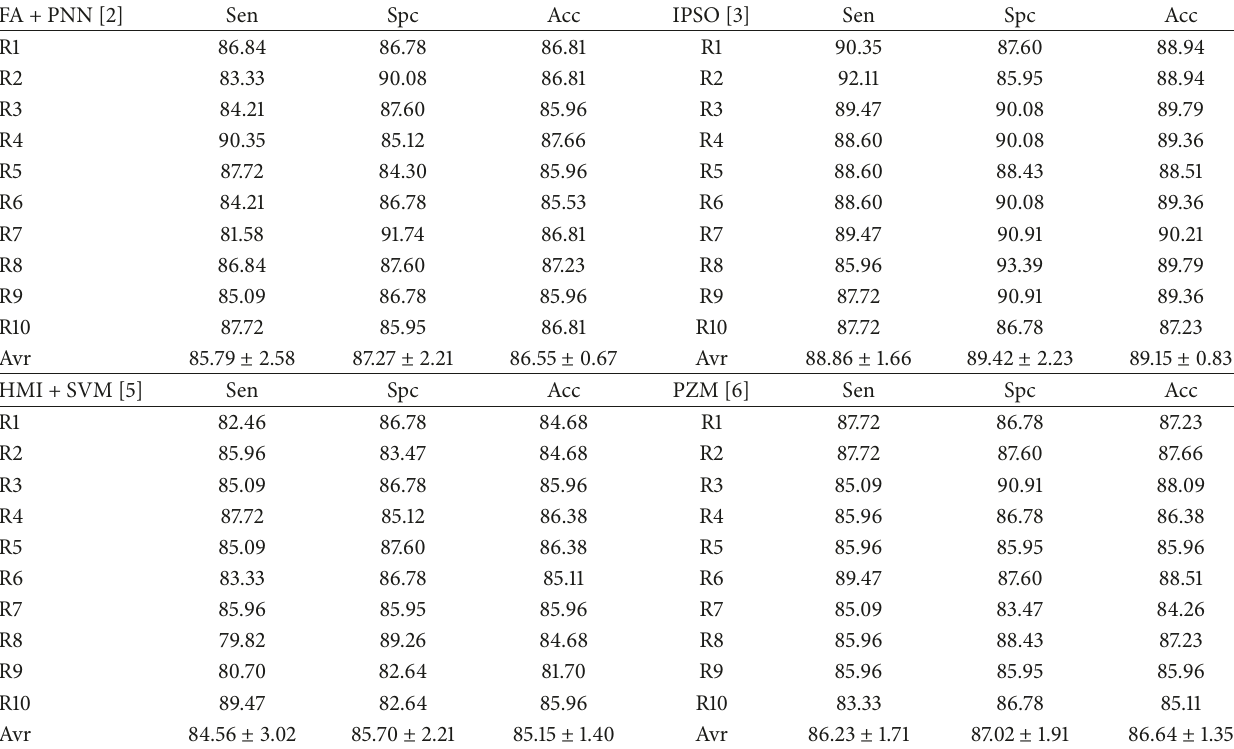
Table 6: Results of 10 × 10-fold cross validation of four state-of-the-art